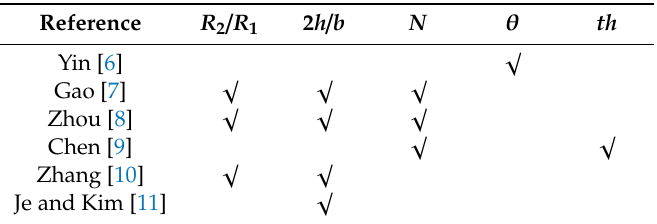
Figure 3. Sketch of a disc bladed impeller (four radial blades are represented in this figure instead of eight).